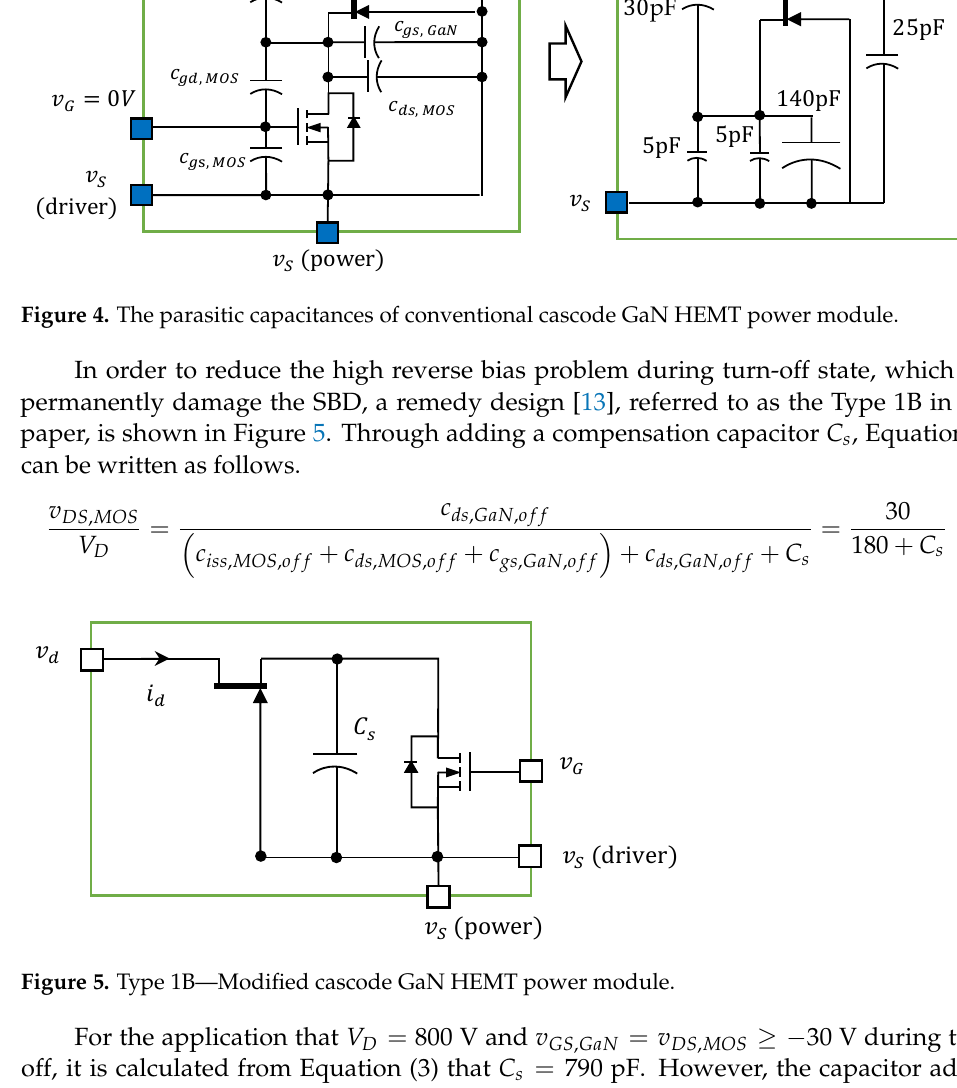
Figure 4. The parasitic capacitances of conventional cascode GaN HEMT power module.